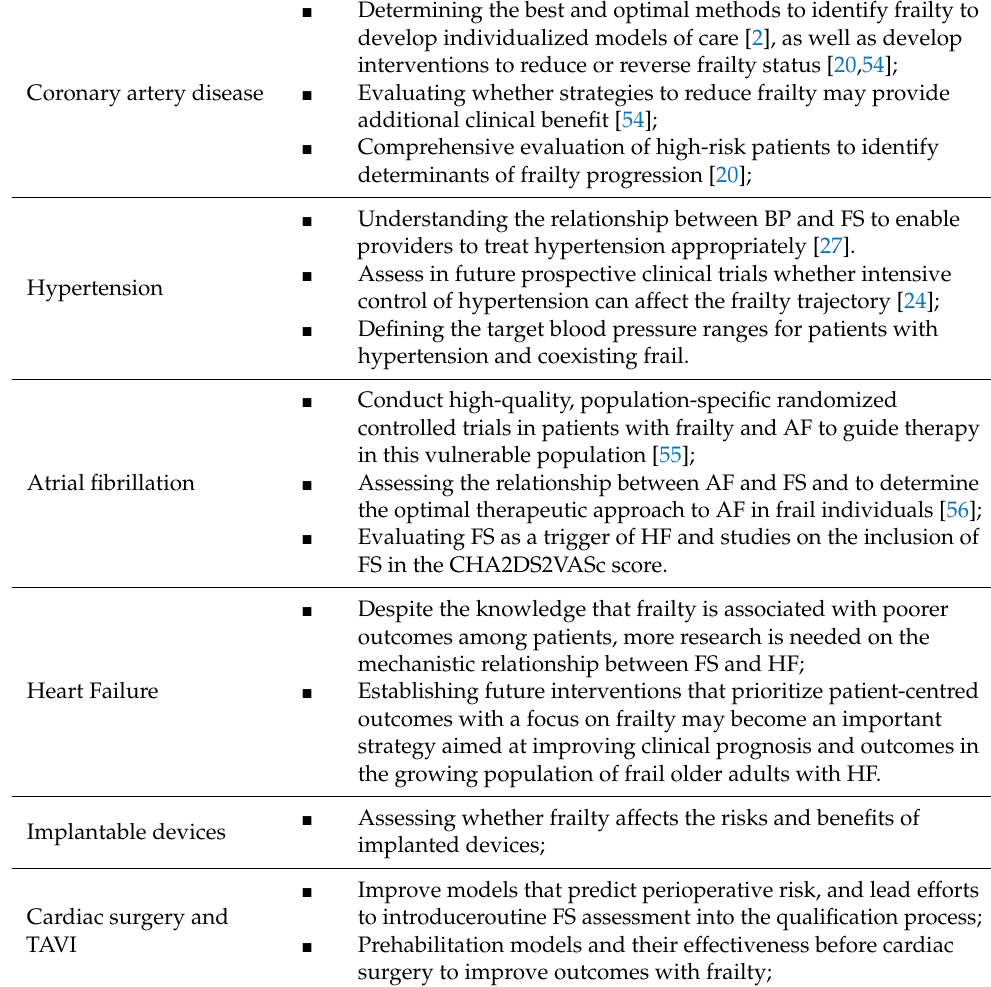
Table 2. Areas that require further research to fully understand the relationship between Frailty syndrome and cardiovascular